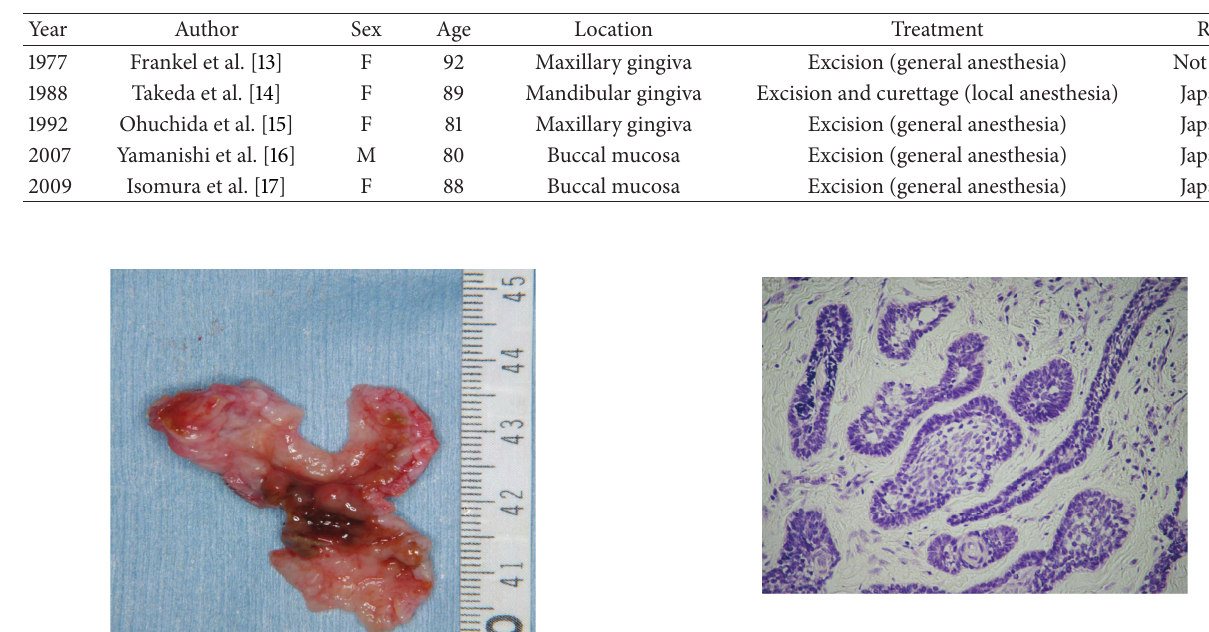
Figure 5: Histopathological findings. Alveolar cell hyperplasia with a funicular structure in the fibrosing interstitial tissue was observed, as well as a palisade arrangement (Haematoxylin and eosin staining, ×